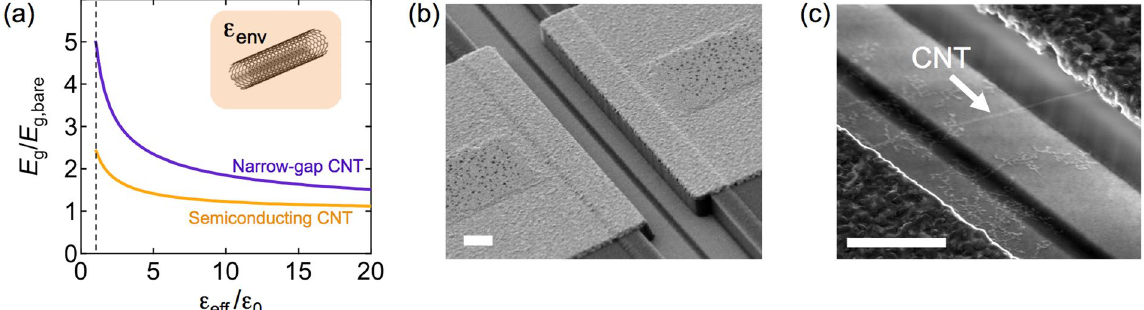
Figure 1. ( a ) Theoretical calculation of the enhancement of the transport gap, E g / E g,bare , as a function of the effective dielectric constant,  , for a narrow-gap with chiral index (24, 0) and semiconducting CNT with chiral eff  is controlled by the dielectric environment. The index (25, 0), both have diameter D ≃ 2 nm. In experiment, eff transport gap calculation is based on a Hartree-Fock self-consistent field calculation that incorporates π -band screening using the static random phase approximation 11, 12 , and includes a contribution due to curvature (see Eqn. 2). Similar enhancement factors are found when D ≃ 1 nm (see Supporting Information). ( b ) Electron microscopy image of the device structure. The source and drain electrodes are separated by 2 μ m. The scale bar is 1 μ m. Catalyst is deposited on top of the electrodes (4- μ m square areas). The two gate electrodes at the bottom of the trench are separated by a 250 nm gap. The gate electrodes are electrically connected (off chip) and operated as a single gate. ( c ) A suspended CNT bridging the gap between source and drain electrodes. The scale bar is 1 μ